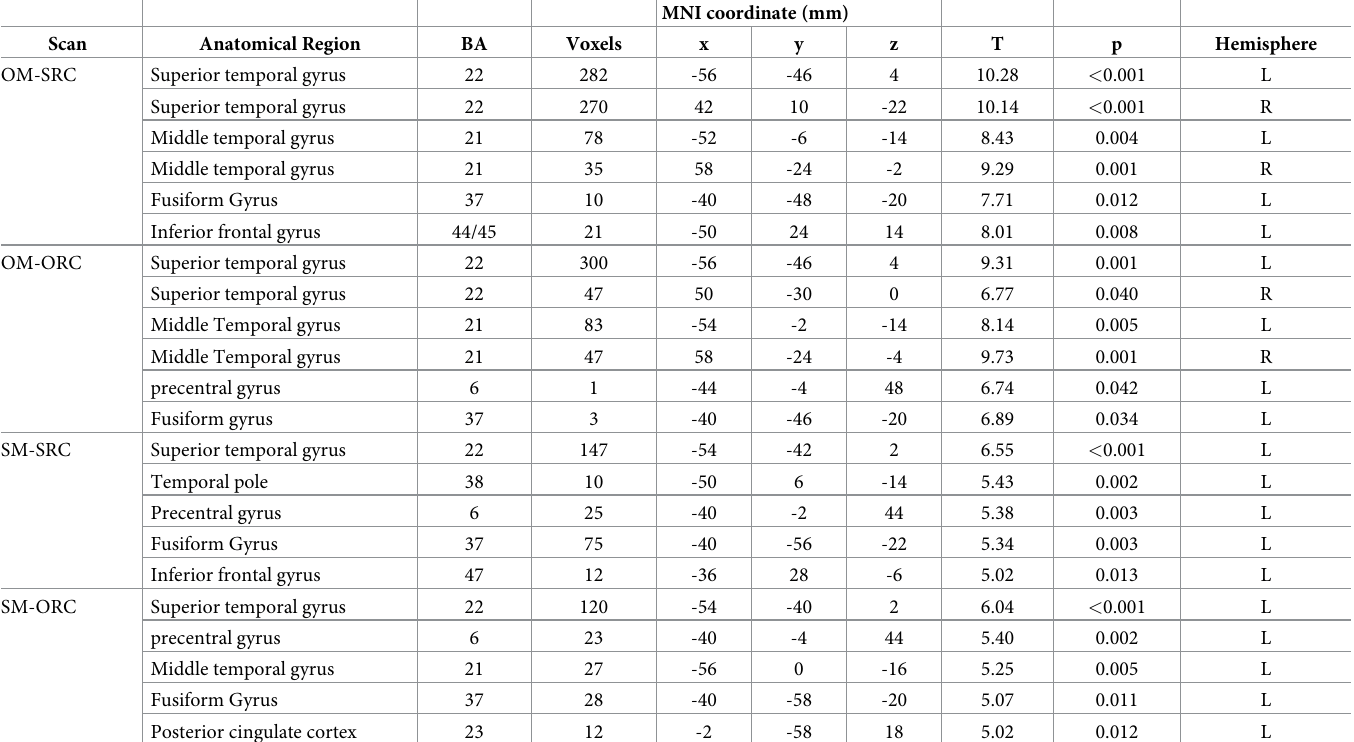
Table 2. Locus and extent of peak activation in brain regions during sentence